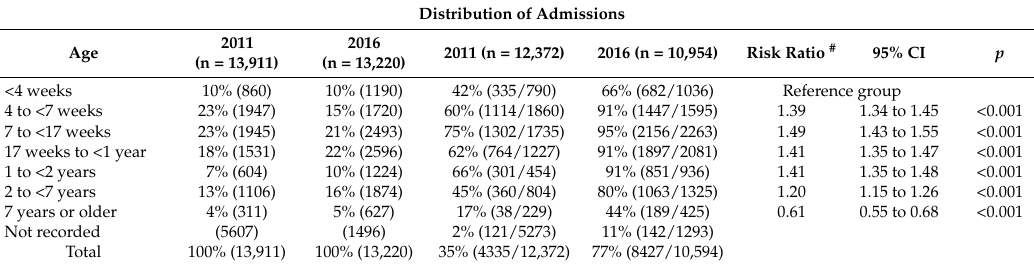
Table 3. Ages of cats on admission to RSPCA Queensland shelters in 2011 and 2016 and percentages rehomed by day 90 and associated risk